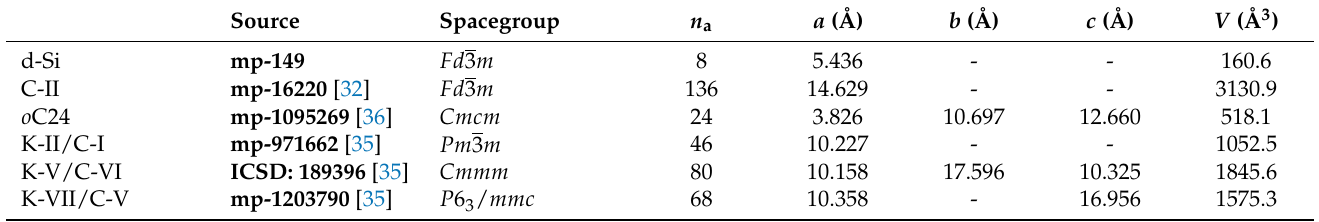
Table 2. List of the six structures examined in this study with the sources of the initial structures (mp— Materials Project; ICSD—Inorganic Crystal Structure Database), the crystallographic spacegroups, and the number of atoms, lattice constants ( a , b , c ) and volumes V of the conventional unit